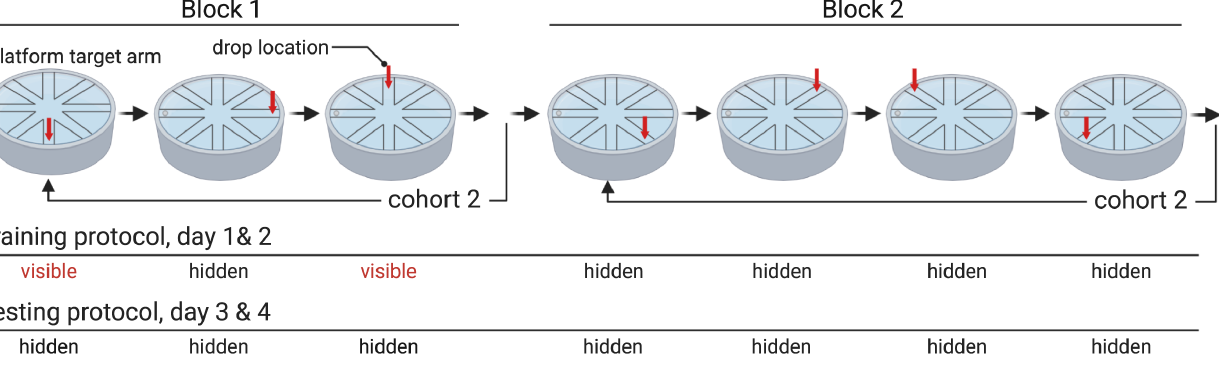
Fig 2. Step-by-Step procedure of RAWM test during training and testing days. During training days (day 1 and 2), the platform is made visible by a flag during block 1 (trial 1 and 3). During the testing days (day 3 and 4), the platform is hidden during all trials. The drop location of the mice varies in a semi- random fashion as shown by the red arrow. To reduce fatigue and learning limitation, a staggered design is used in RAWM test, with one cohort (10–15 mice) tested in a block before and then a second cohort is tested. Time between trials for each mouse is on average 15–20 minutes, and on average the time between blocks is 60–75